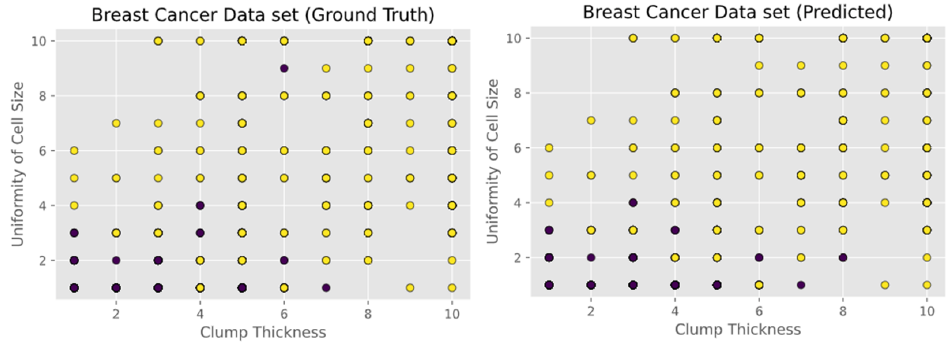
Figure 16. Ground truth vs. predicted labels from FNN-PSO algorithm on Breast Cancer.